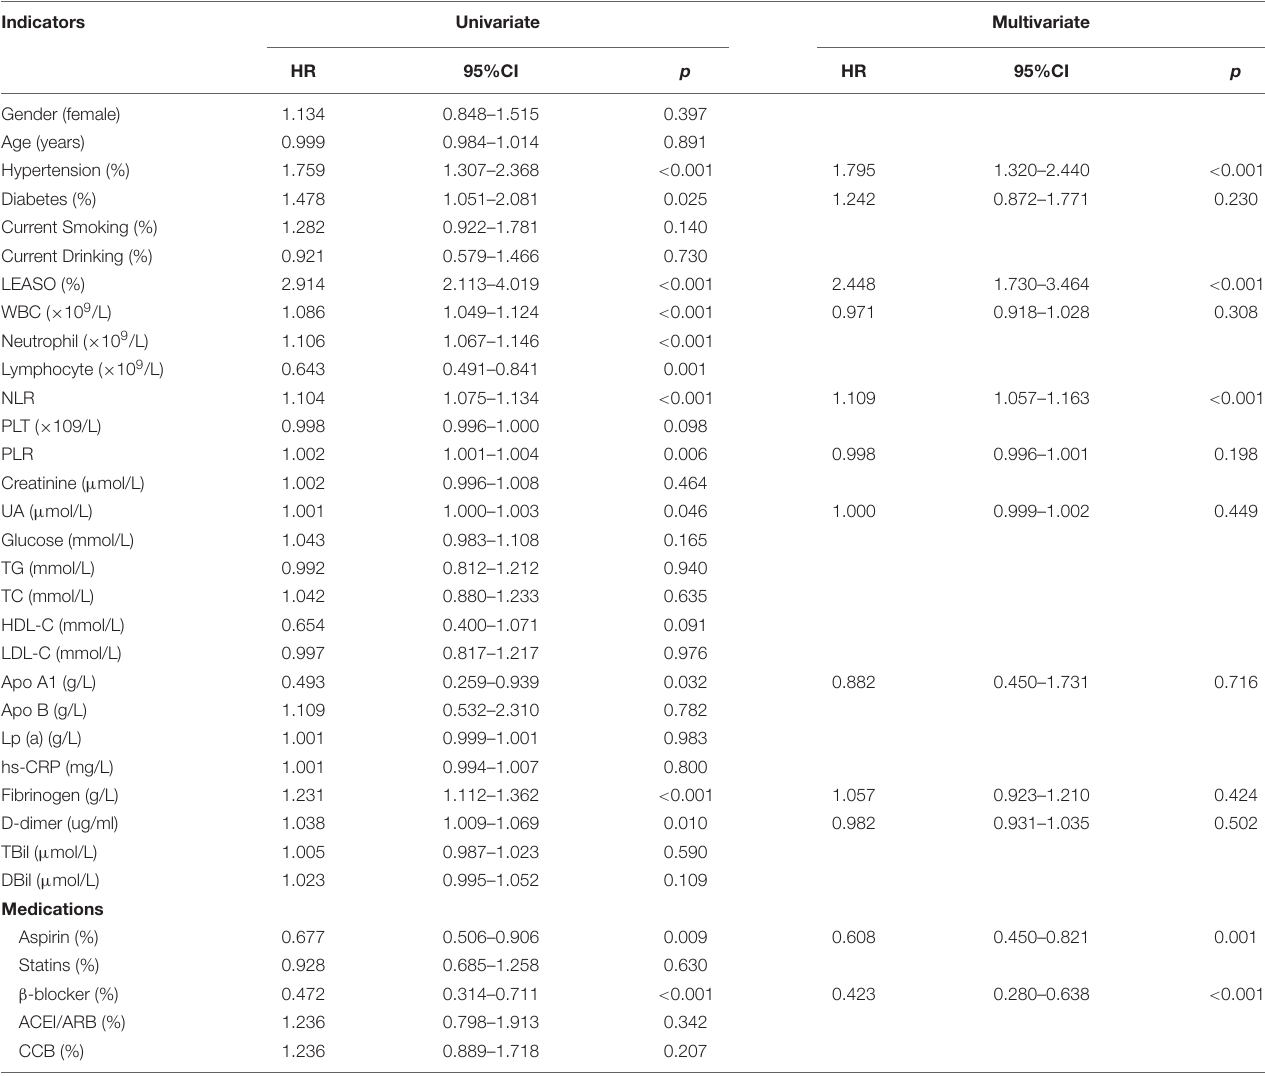
TABLE 3 | Predictors of the occurrence of MACCEs in LEASO patients: results of univariate and multivariate Cox-regression analyses. Indicators Univariate